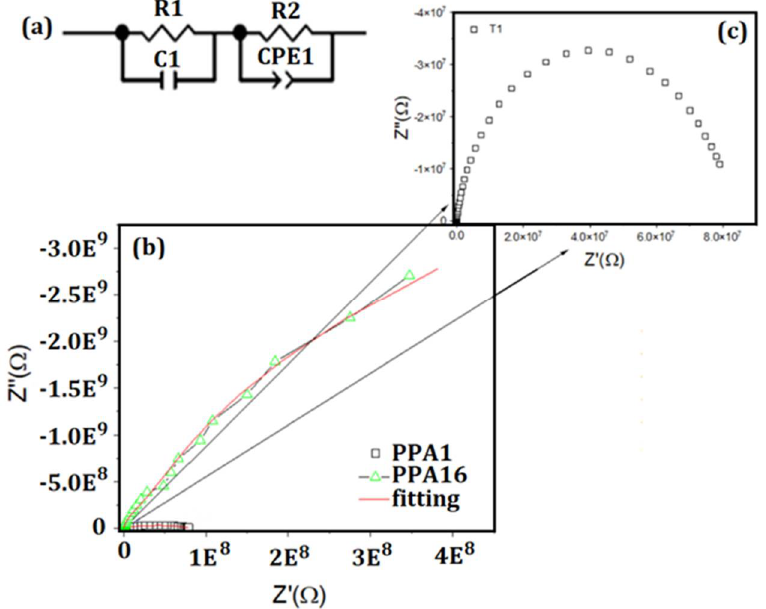
Figure 11. ( a ) Equivalent circuit used for sample adjustment; ( b ) Cole–Cole diagram with symbols for the different polymers; ( c ) enlargement of the Cole–Cole diagram of the PPA1 HT polymer. The solid red lines represent the adjustment by the equivalent circuit in the